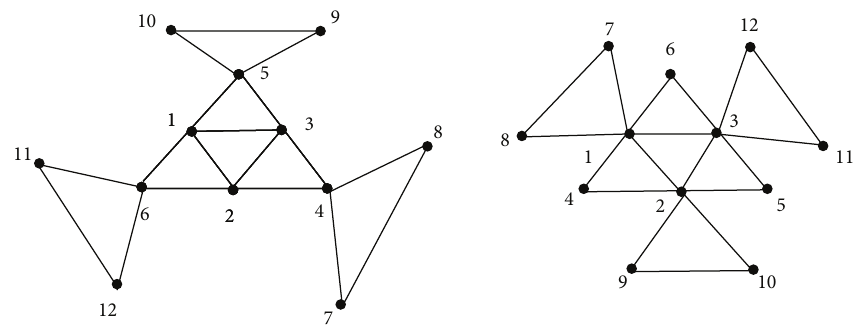
Figure 1: 𝐶 3 ⊙ 𝑄 𝑃 2 and 𝐶 3 ⊖ 𝑄 𝑃 2